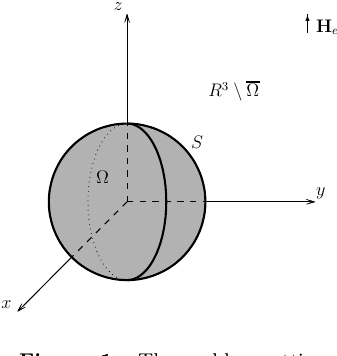
Figure 1. The problem